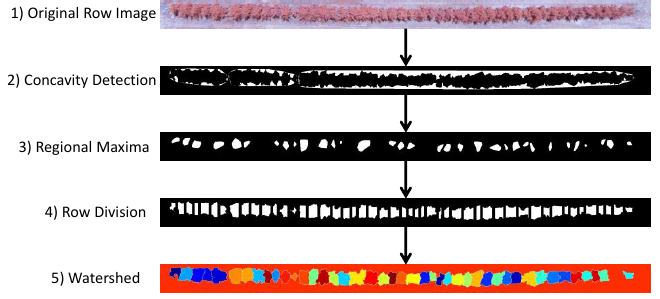
Figure 8. Image processing algorithm for tree identification.